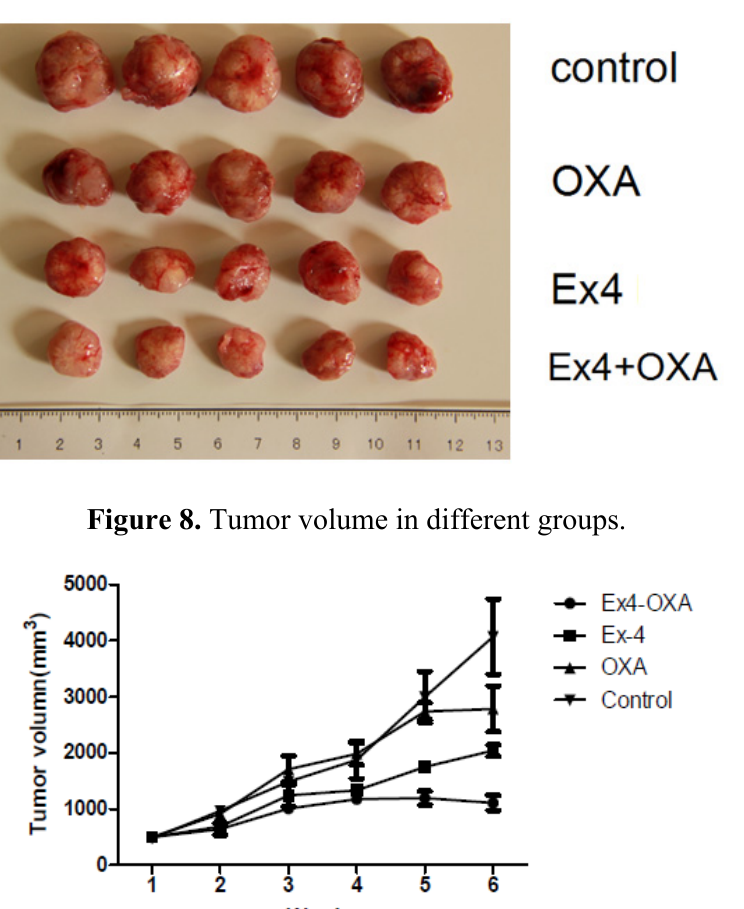
Figure 7. Nude mice bearing tumor.